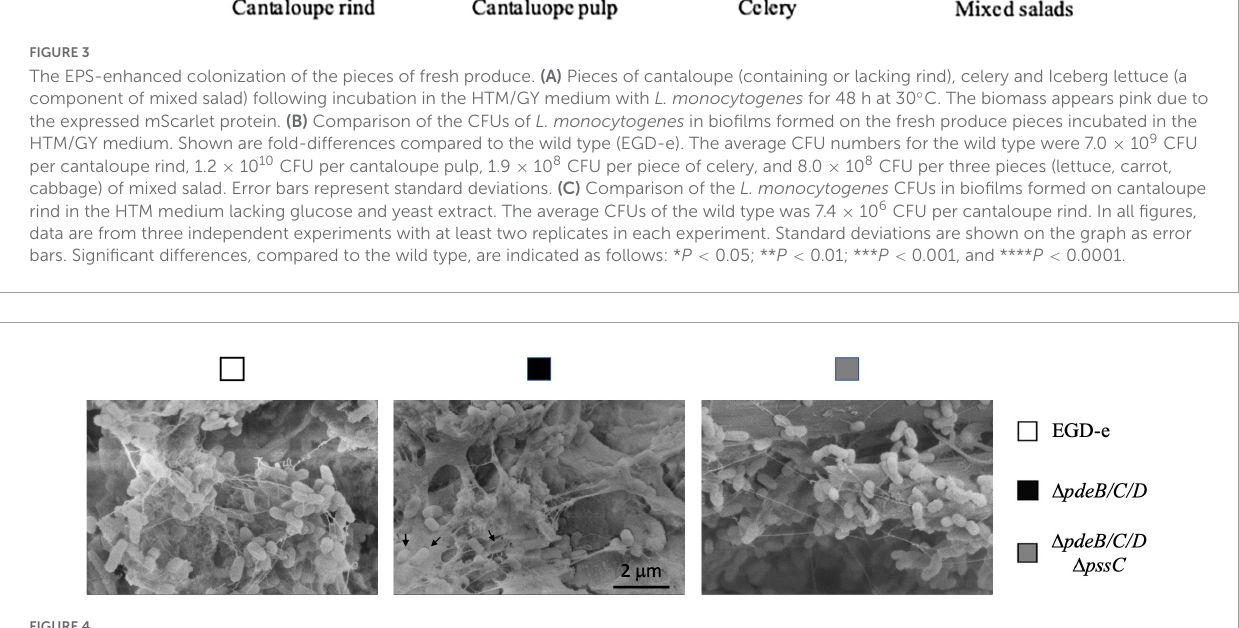
FIGURE4 The SEM images of L. monocytogenes biofilms formed on cantaloupe rind. Bacterial cells embedded in the EPS matrix and presumed empty shells around bacteria removed during sample preparation (black arrows) are seen in the EPS-synthesizing strain but not in the wild type and EPS-impaired strains. Magnification, 40,000 ×